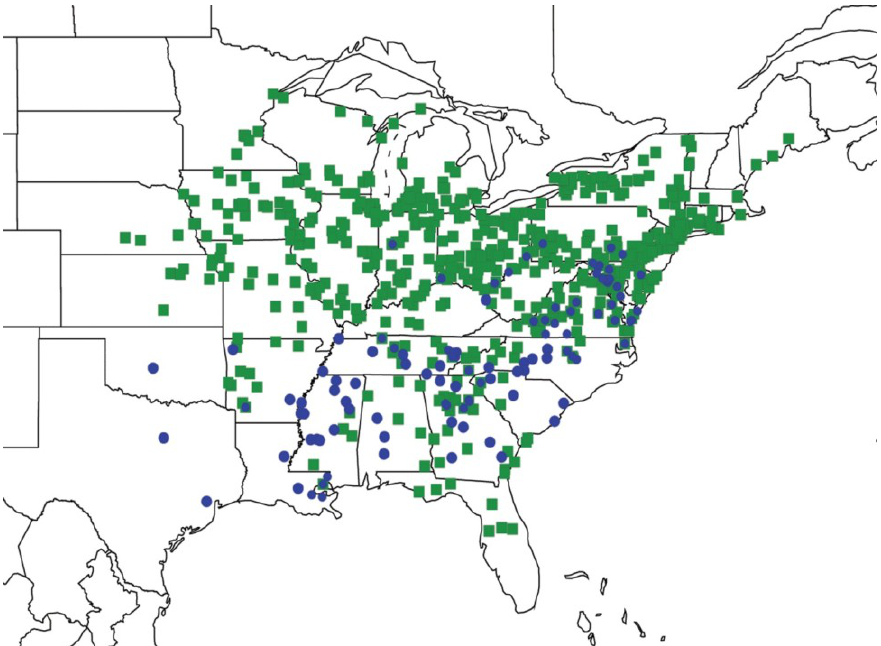
Figure 14. Distribution of Tibicen winnemanna (blue circles) and T. linnei (green